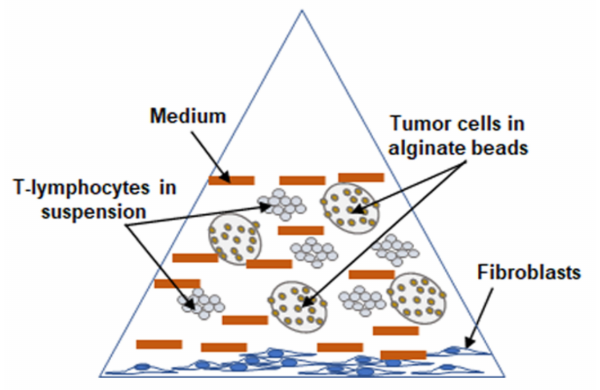
Figure 1. Schematic representation of the working model showing the experimental setup under pro-inflammatory multicellular-TME culture